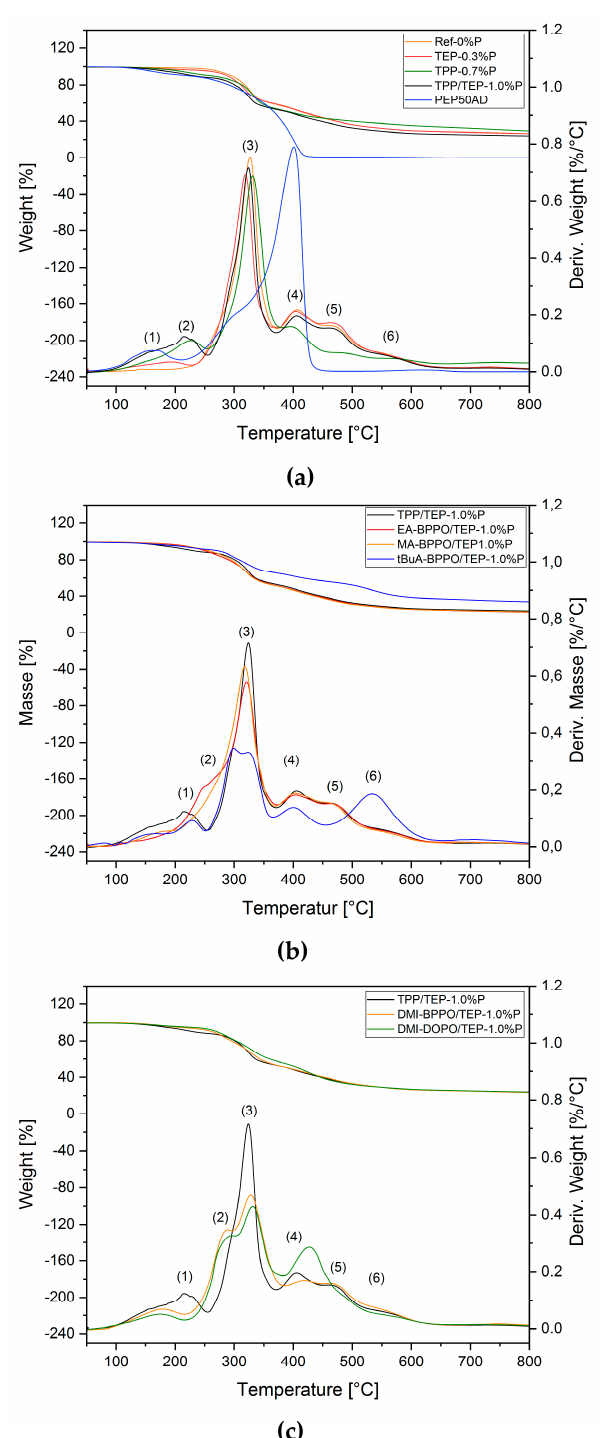
Figure 5. Thermogravimetric analysis (TGA) results: ( a ) TGA curves of benchmark foams and polyol used; ( b ) TGA curves of the benchmark foam compared to foams containing BPPO-derivatives; and, ( c ) TGA curves of the benchmark foam compared with a foam with BPPO-derivative and a DOPO-derivative. All the formulations shown here are specified in Table S1 in the Supporting Information.